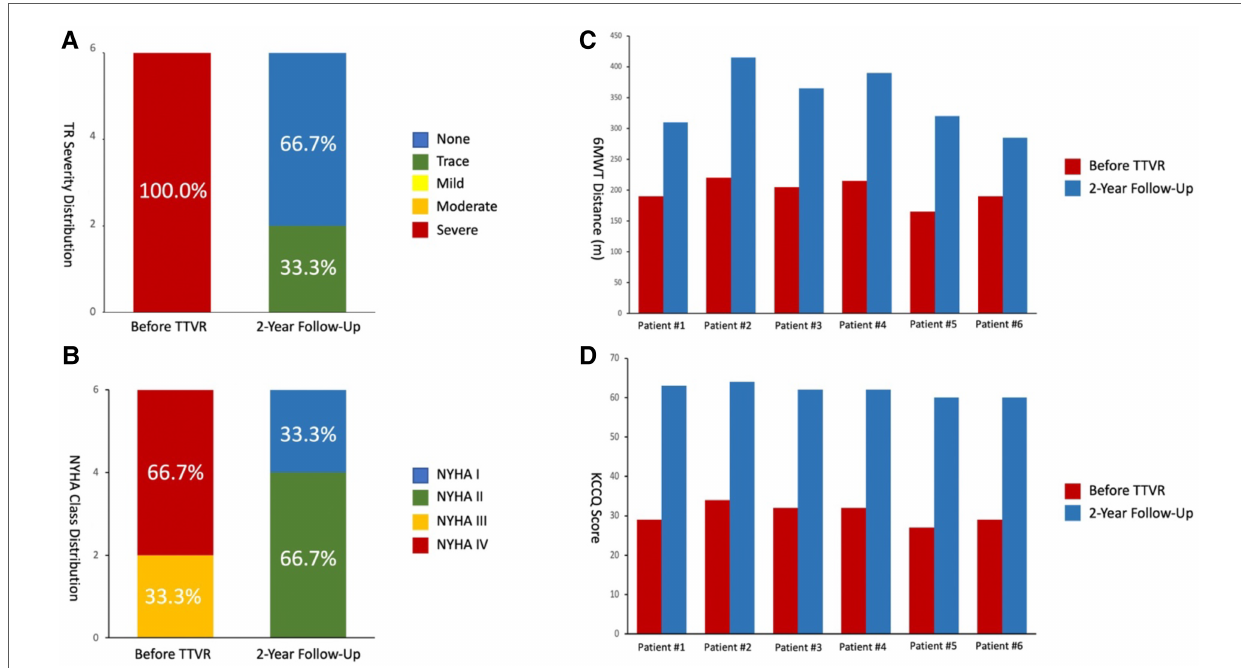
FIGURE 7 2-year follow-up results showed reduced TR severity and improved clinical, functional, and quality-of-life outcomes. ( A ) Assessment of TR severity. P value from Wilcoxon signed rank test. ( B ) Comparison of NYHA functional class between pre-procedures and 2-year follow-up. P value from